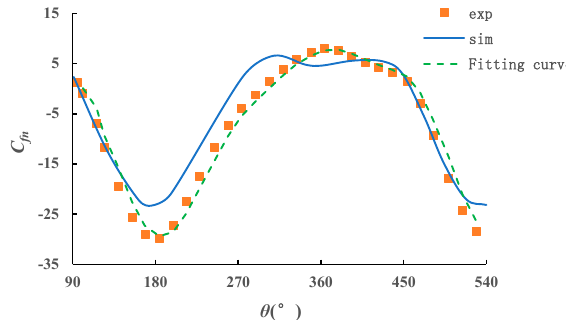
Figure 10. Comparison of normal force coefficient between numerical simulation results and experimental results in the literature.